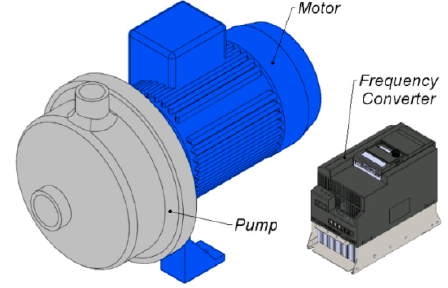
Figure 2. Sketch of the pump unit.